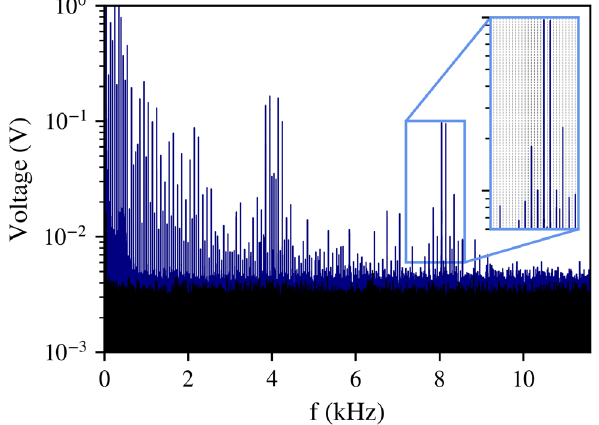
FIG. 26. The UPS output voltage spectrum in normal operation mode (blue) and with a zoomed window (light blue). The vertical gray lines represent the multiples of 50 Hz. The spectrum measured due to environmental noise is also illustrated (black).